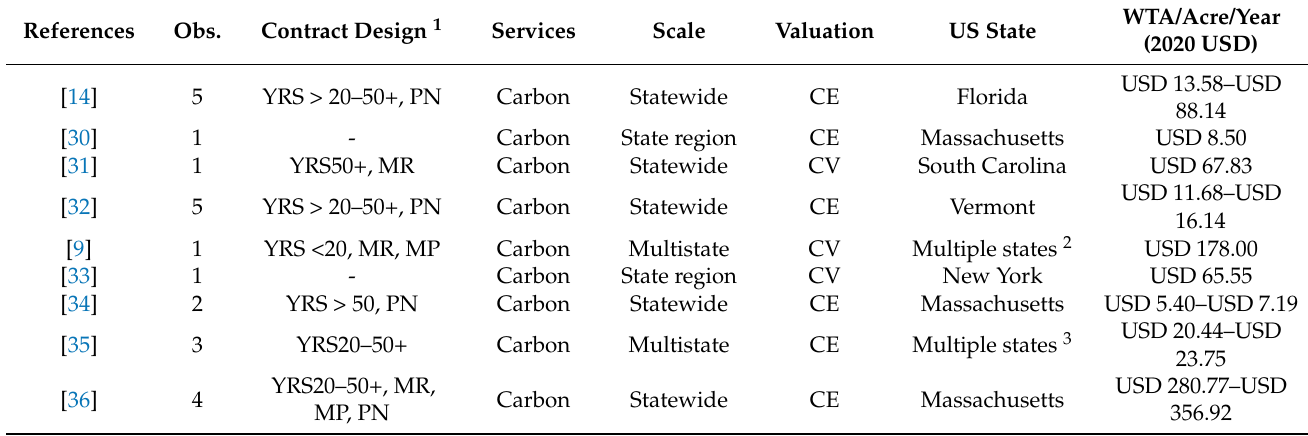
Table 1. Summary of studies estimating forest owner willingness to accept (WTA) payment for managing forest